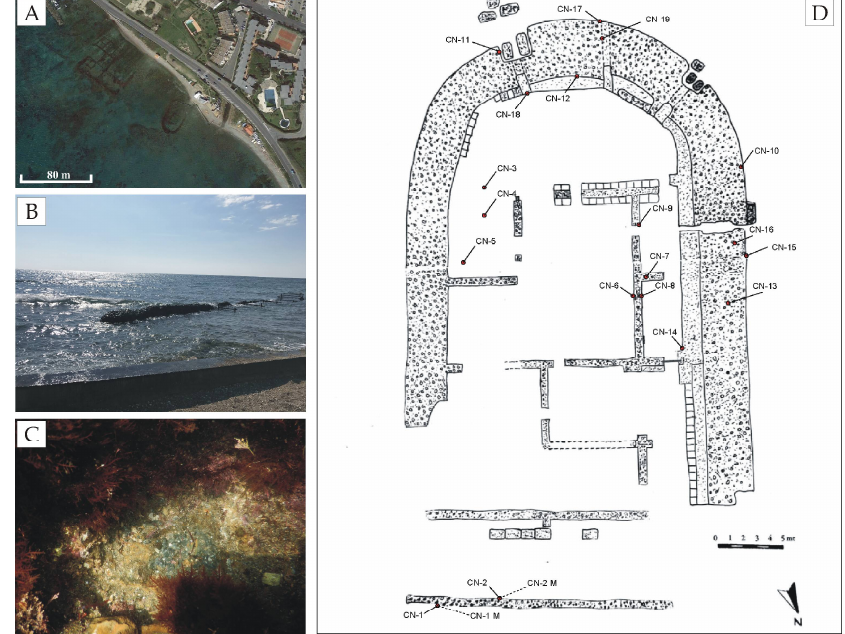
Figure 1. ( A ) Location of Castrum Novum archaeological site; ( B ) photo of the fishpond partially outcropping above sea level; ( C ) underwater photo of the fishpond; ( D ) sketch of the apsidal fishpond composed of only one tank.